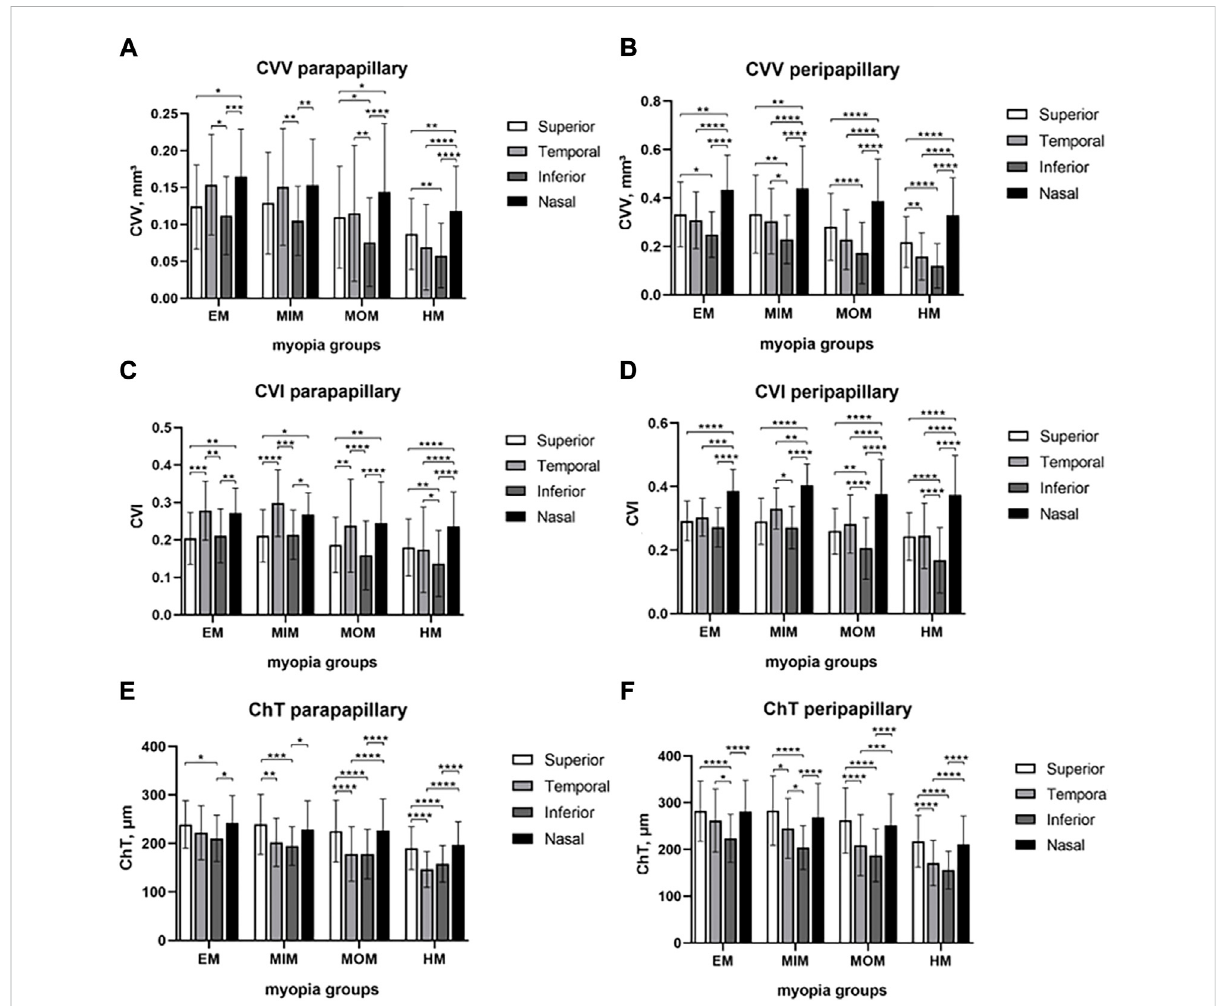
FIGURE 4 Comparison of CVV, CVI, and ChT in papillary regions among four quadrants ofdifferent myopic groups. (A) CVV in the parapapillary region. (B) CVVintheperipapillary region. (C) CVIintheparapapillaryregion. (D) CVIintheperipapillaryregion. (E) ChTintheparapapillaryregion. (F) ChTinthe peripapillaryregion.Statistical signi fi cancewasmarkedas *( p < 0.05), **( p < 0.01), ***( p < 0.001), and **** ( p < 0.0001). EM, emmetropia; MIM,mild myopia; MOM, moderate myopia; HM, high myopia; CVV, choroidal vessel volume; CVI, choroidal vessel index; ChT, choroidal